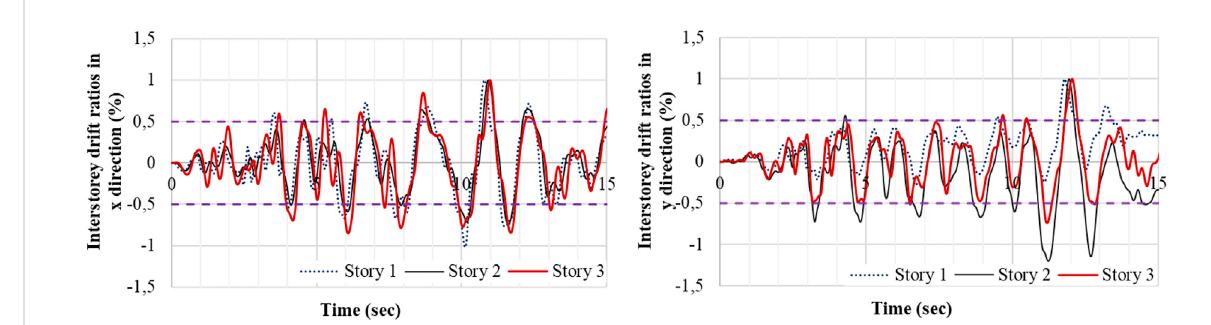
FIGURE 13 Interstory drift ratios for the Chuetsu Oki (Japan) record.